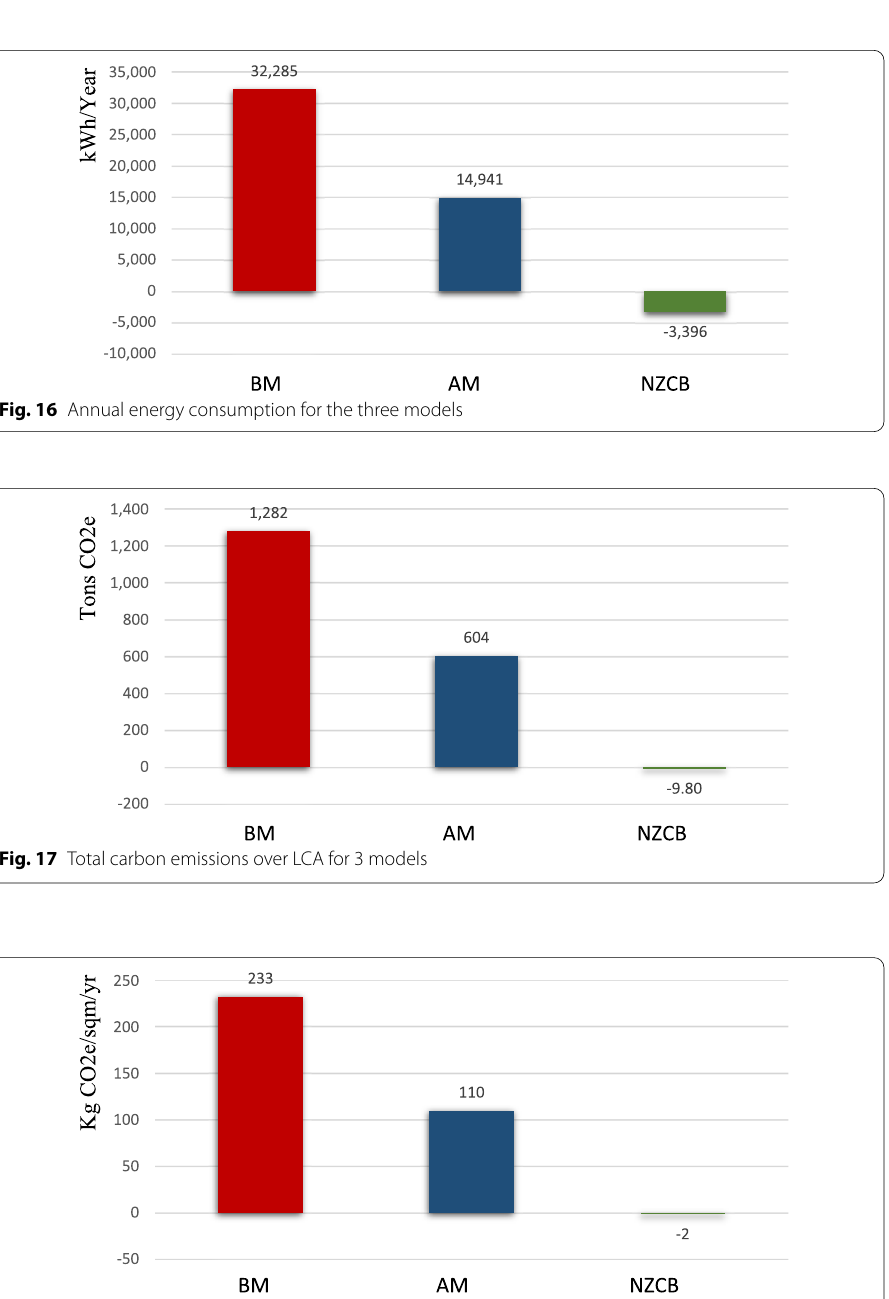
Fig. 18 Total carbon emissions for 3 models in kg CO 2